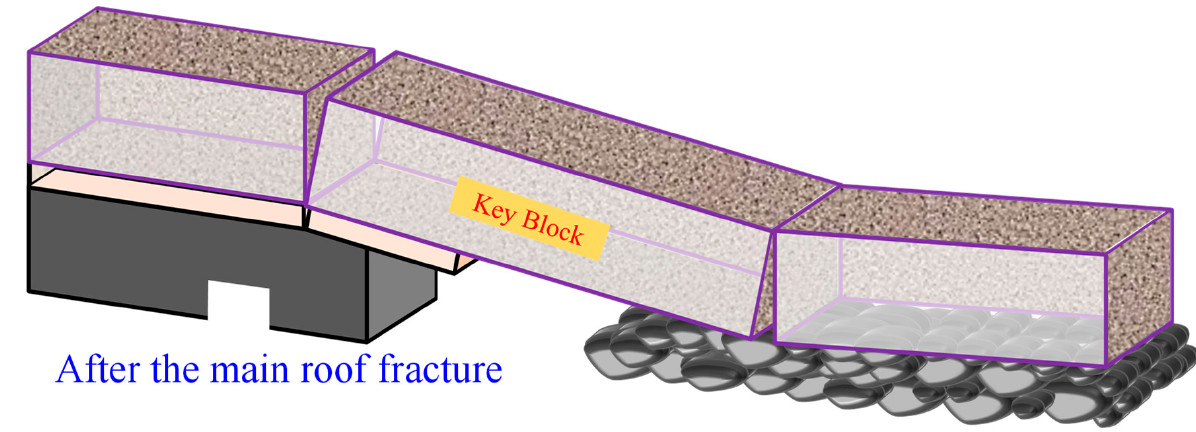
Figure 11. Overburden rock structure.